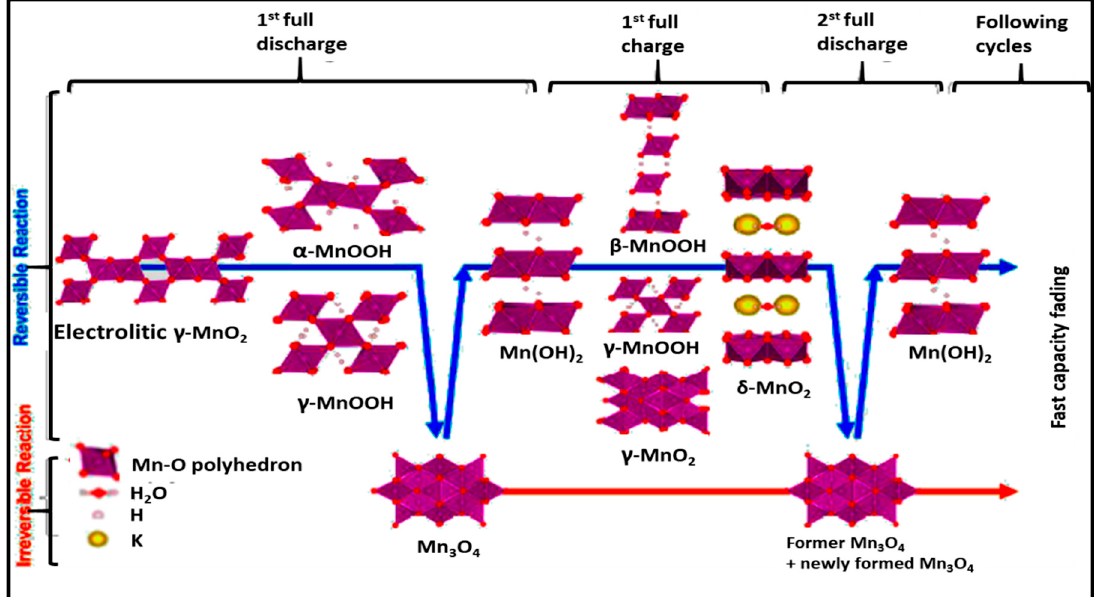
Figure 3. Reaction mechanism of γ -MnO 2 cathode in a standard alkaline battery. Reproduced with permission from [24]. Copyright 2016 the American Chemical Society.